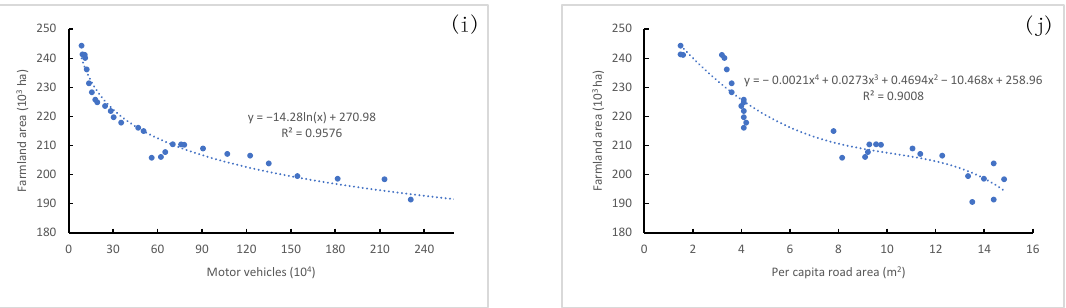
Figure 6. Relationships between farmland area and ( a ) total population, ( b ) non-agricultural population, ( c ) GDP, ( d ) primary industry output, ( e ) secondary industry output, ( f ) tertiary industry output, ( g ) fixed asset investments, ( h ) local revenues, ( i ) motor vehicles and ( j ) per capita road area during 1987–2016 in Wuhan.